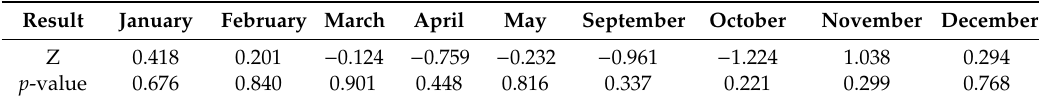
Table 4. Results of the Mann–Kendall trend test at the 5% significance level for the monthly SPI data shown in Figure